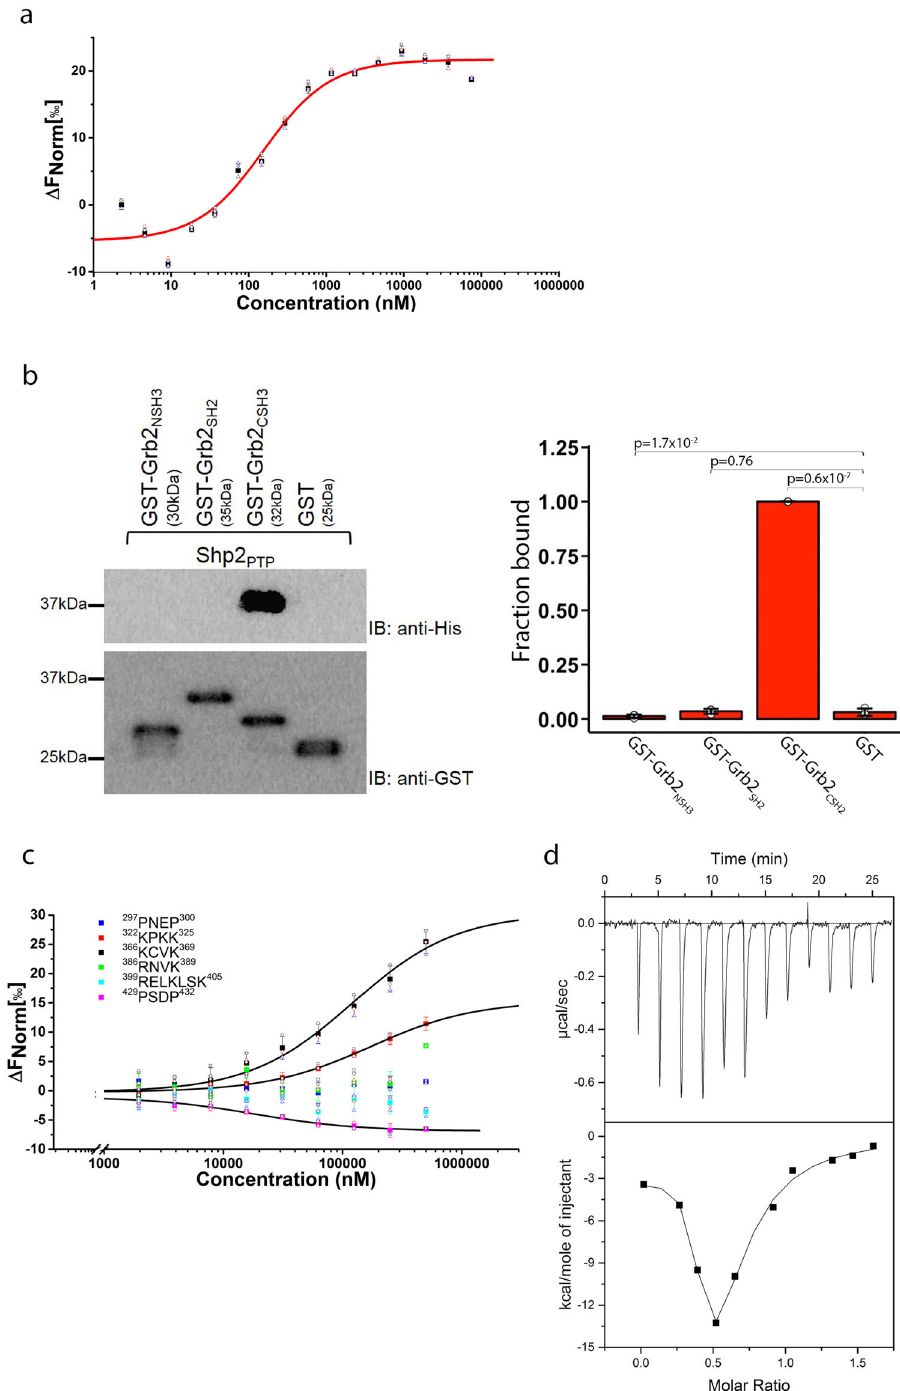
Fig. 3 Characterisation of Grb2 Y160E binding to Shp2 PTP domain. a MST measurement of Shp2 PTP binding to fl uorescent labelled Grb2 Y160E (0.1 µ M). Both PTP domain and tandem 2SH2 domains show similar af fi nity to Grb2 Y160E . Data are presented as (mean ± SD) of technical triplicates. b GST pull-down experiment using GST-tagged individual Grb2 domain (NSH3, SH2 and CSH3) to precipitate Shp2 PTP domain. The result clearly indicates the interaction is mediated through Grb2 CSH3 domain. The blot represents three independent experiments. Inset: densitometric analysis of GST pull-down results. Results are represented as mean ± SD. Statistics were determined using an unpaired Student ’ s t test. c Sequence analysis identi fi es six potential PxxP or R/KxxK (x is any amino residue) motifs for Grb2 CSH3 domain interaction. Synthesised peptides were used to test the interactions with Grb2 CSH3 domain (Atto 488 labelled, 0.1 µ M) using MST. The results show 322 KPKK 325 , 366 KCVK 369 and 429 PSDP 432 interact with Shp2 PTP domain. Motif 429 PSDP 432 binds to Shp2 PTP domain with the highest af fi nity of 18 µ M. See Table for detailed information and peptide sequences. Data are presented as (mean ± SD) of technical replicates (peptide 322 – 325 and peptide 429 – 432) or triplicates. d ITC was used to corroborate the two binding events between Shp2 and Grb2 Y160E . Grb2 Y160E (200 µ M) was titrated into Shp2 Δ 69 (25 µ M). Twelve 3 µ l injections of Grb2 Y160E were titrated into Shp2 Δ 69 . Top panel: baseline-corrected power versus time plot for the titration. Bottom panel: the integrated heats and the molar ratio of the Grb2 Y160E to Shp2 Δ 69 . COMMUNICATIONS BIOLOGY| (2021) 4:437